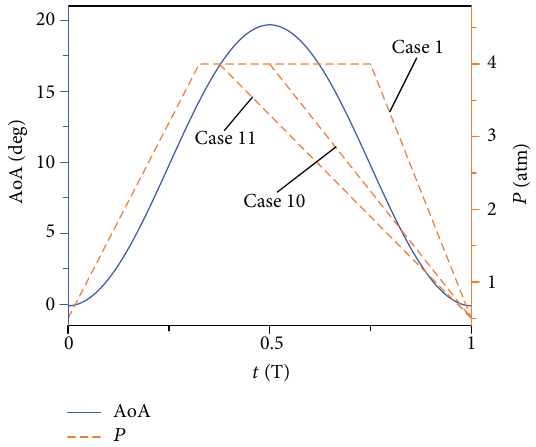
Figure 36: Control laws of in fl ation and de fl ation for Cases 1, 10, and 11.